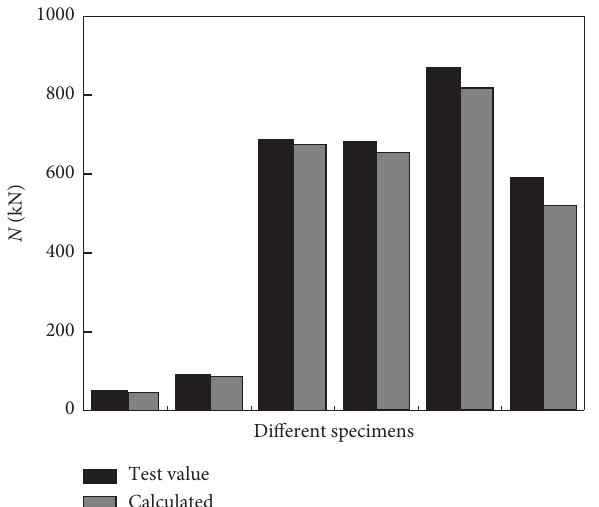
Figure 22: Comparison of measured bearing capacity and calculated bearing capacity: (a) N and (b) comparison of test ultimate bearing capacity and calculated value.